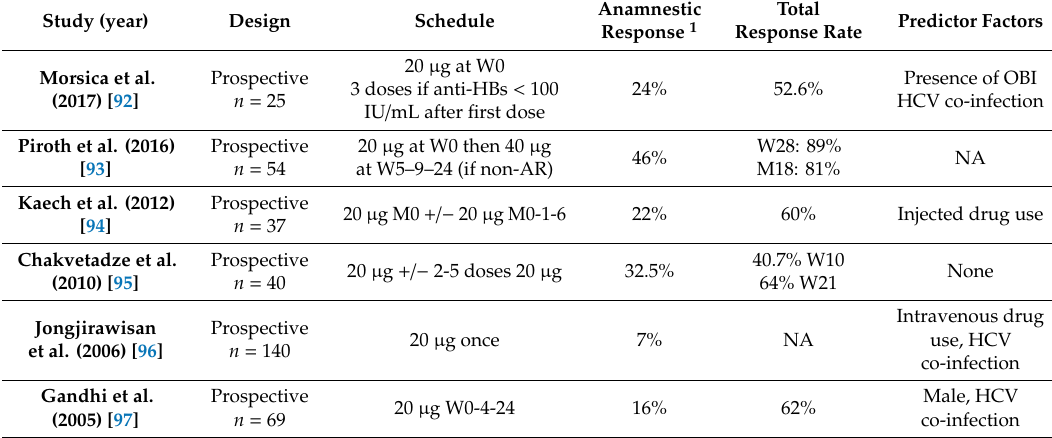
Table 3. HBV Vaccination in HIV-infected patients with isolated